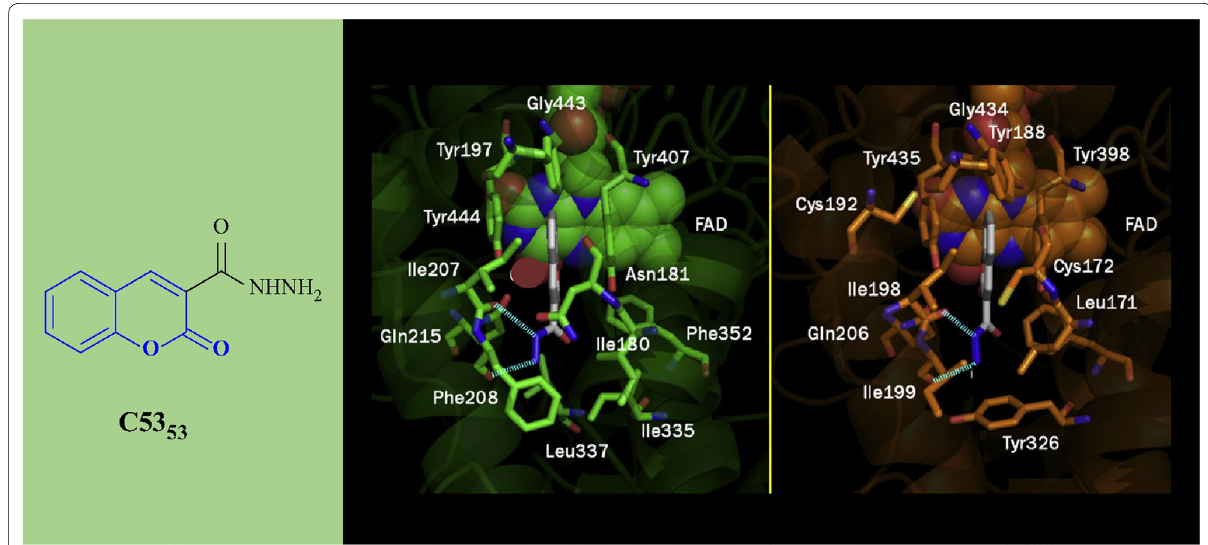
Fig. 57 Most stable binding of C53 53 with respect to hMAO-A (left side) and hMAO-B (right side). Ligands are shown in CPK colored sticks, interacting residues are coloured in green (hMAO-A) or orange (hMAO-B) carbons in sticks rendering. FAD is reported in spacefill with green (hMAO-A) or orange (hMAO-B) carbon atoms. Non-interacting aminoacids are in transparent green (hMAO-A) or orange (hMAO-B) cartoon notation. Inhibitor-enzyme hydrogen bonds are reported in cyan dashed lines [89]